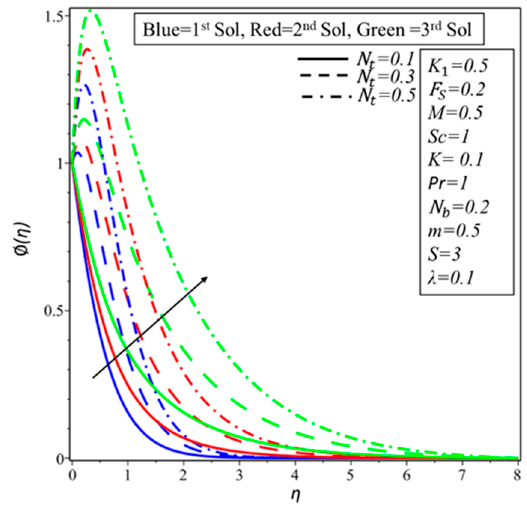
Figure 14. Nanoparticle concentration profiles for increasing values of N t .